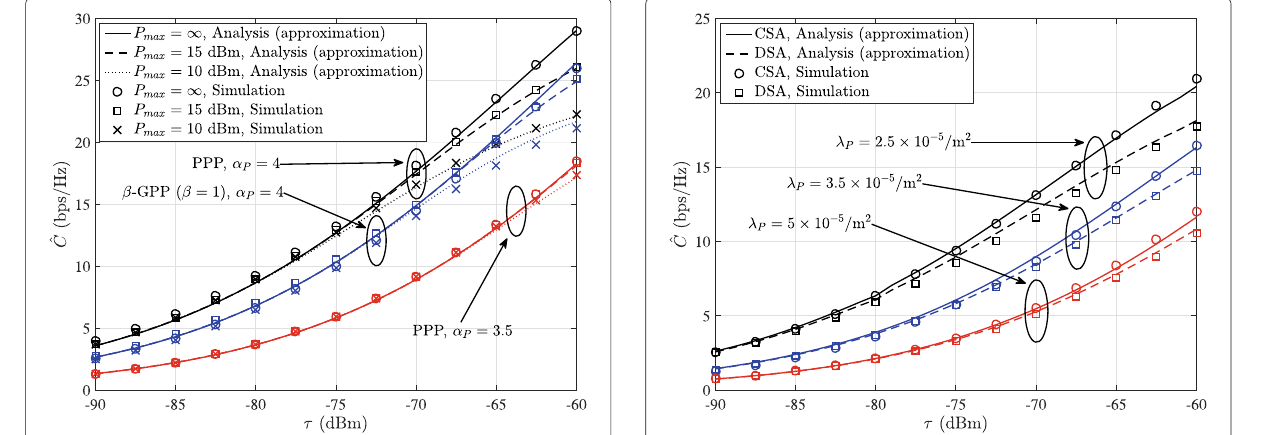
Fig. 5 The total average SU achievable rate ˆ C as a function of τ when the maximum transmit power constraint is considered